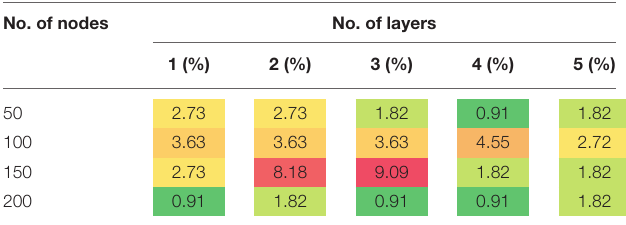
TABLE 5 | The improvement of the DNN-FS in different scenarios compared with the DNN-woFS. No. of